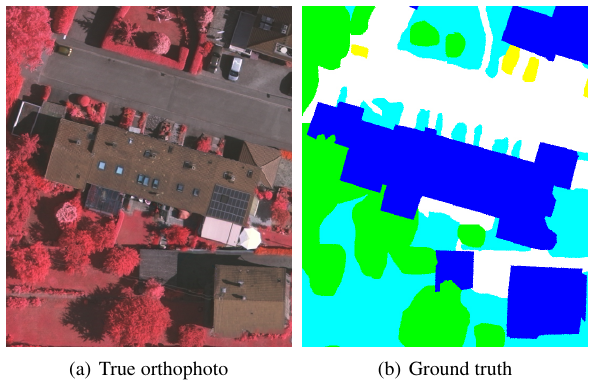
Figure 1. An example patch is taken from the ISPRS Vaihingen dataset. There are great differences in the size and shape of objects. The classes of interest are given by Impervious Surfaces (white), Building (blue), Low Vegetation (cyan), Tree (green) and Car